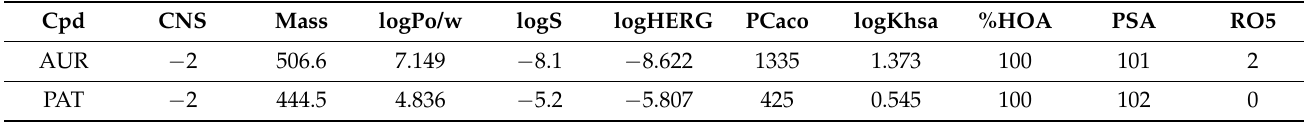
Table 4. The representative physicochemical properties and drug-like properties of auranamide and